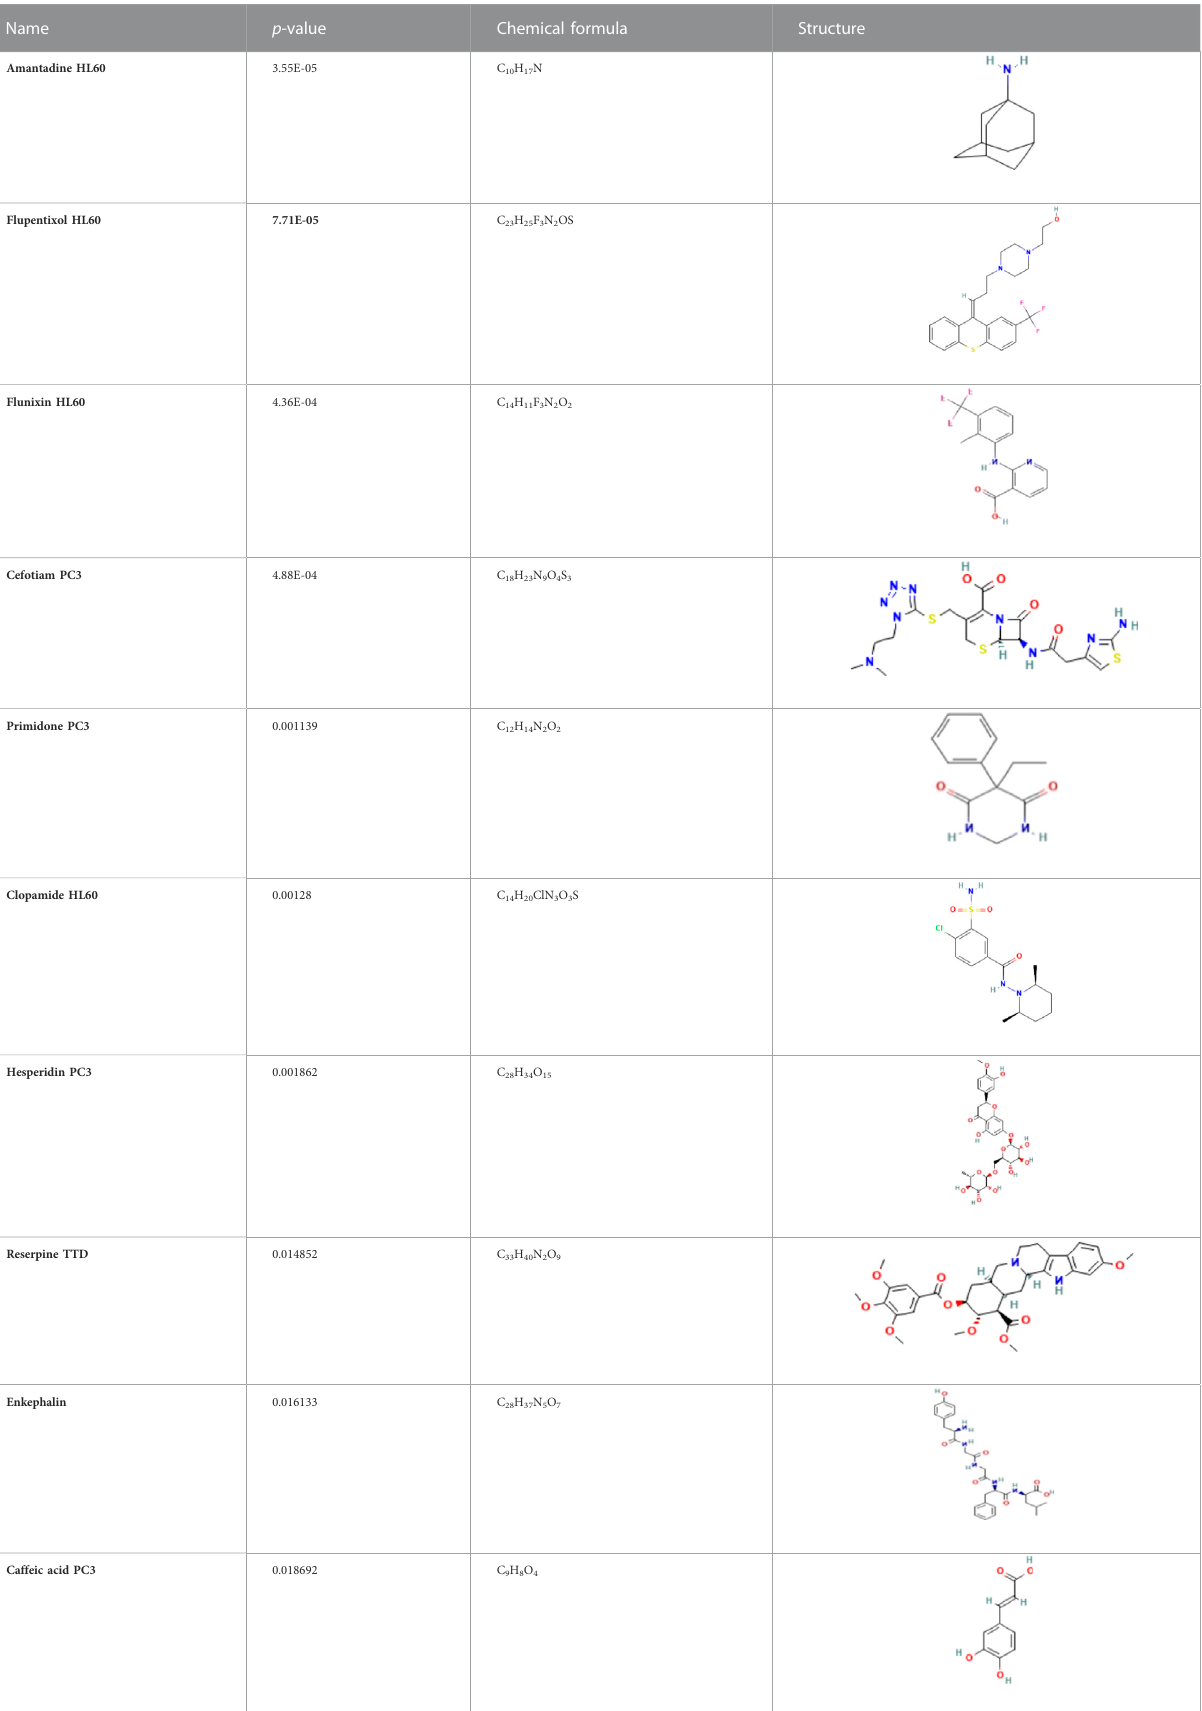
TABLE 1 List of drugs recommended for treating AD by targeting CCT2